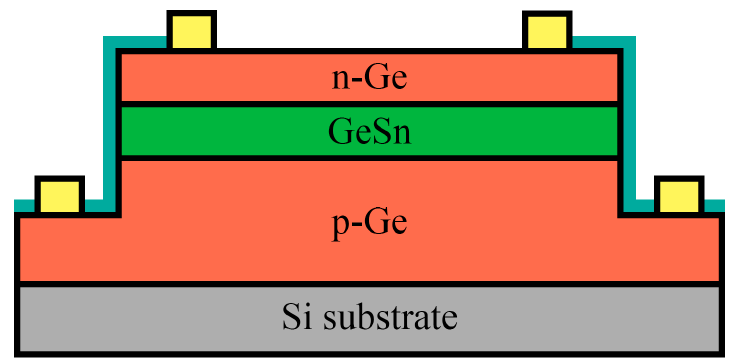
Figure 3. Schematic cross-sectional view of the GeSn on Ge p-i-n photodetector. There were two samples with 7% and 10% tin. Electrical and optical characteristics were investigated for both samples. The reverse current density increased with the temperature as a result larger number of thermally activated carriers. The 10% Sn device showed higher current densities compared to that of the 7% Sn device at equal conditions due to the narrower bandgap, which also resulted in the larger number of thermally excited carriers. Other parameters were also studied such as detectivity for both samples. They have shown very close values under the same conditions [26]. This study has shown good performance and detectivity compared with the detectors dominating the market.